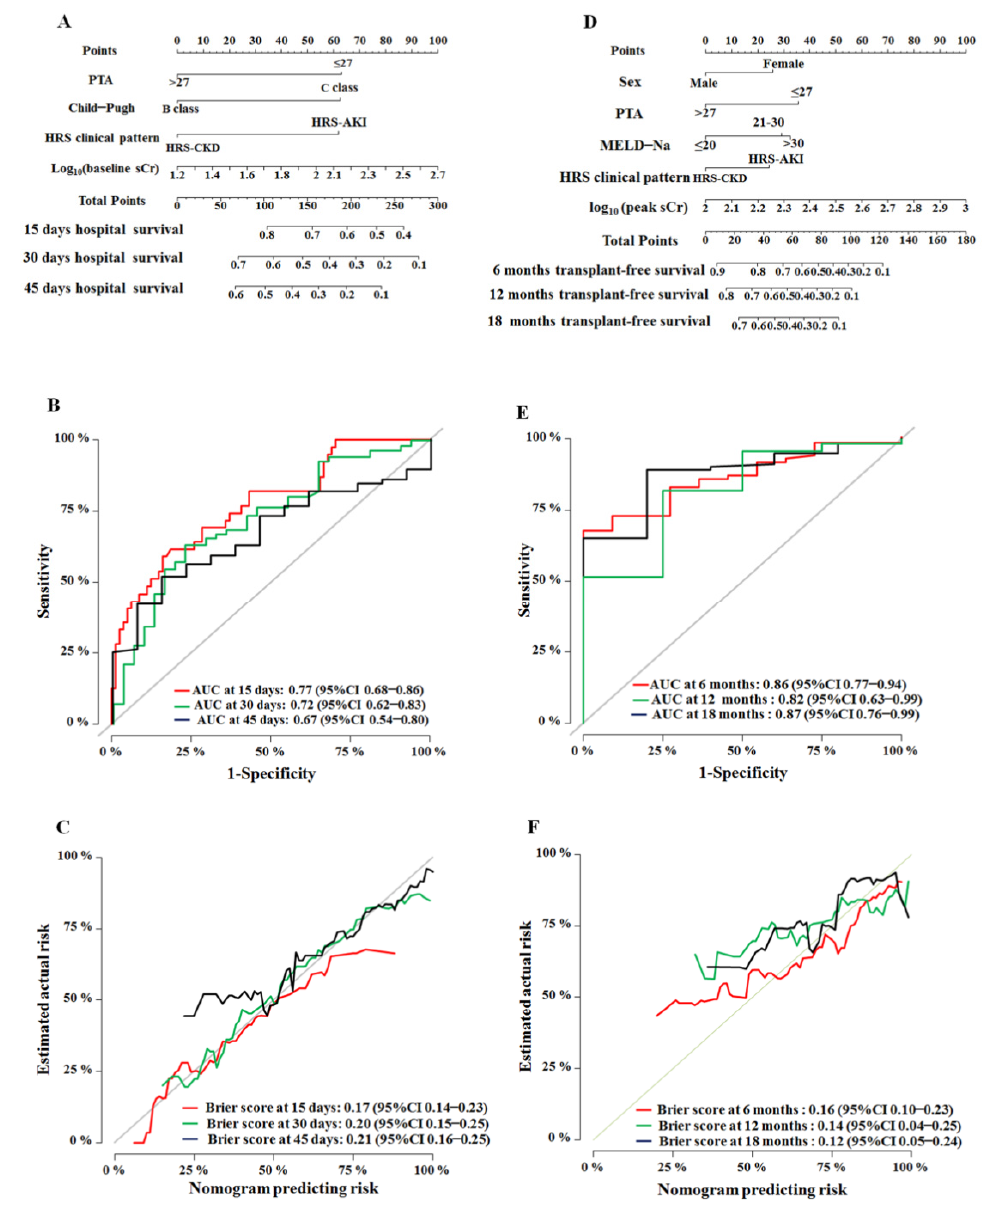
Figure 3. Development and internal validation of the hospital survival and transplant-free survival nomograms. ( A ) The hospital survival nomogram. The nomogram was based on four